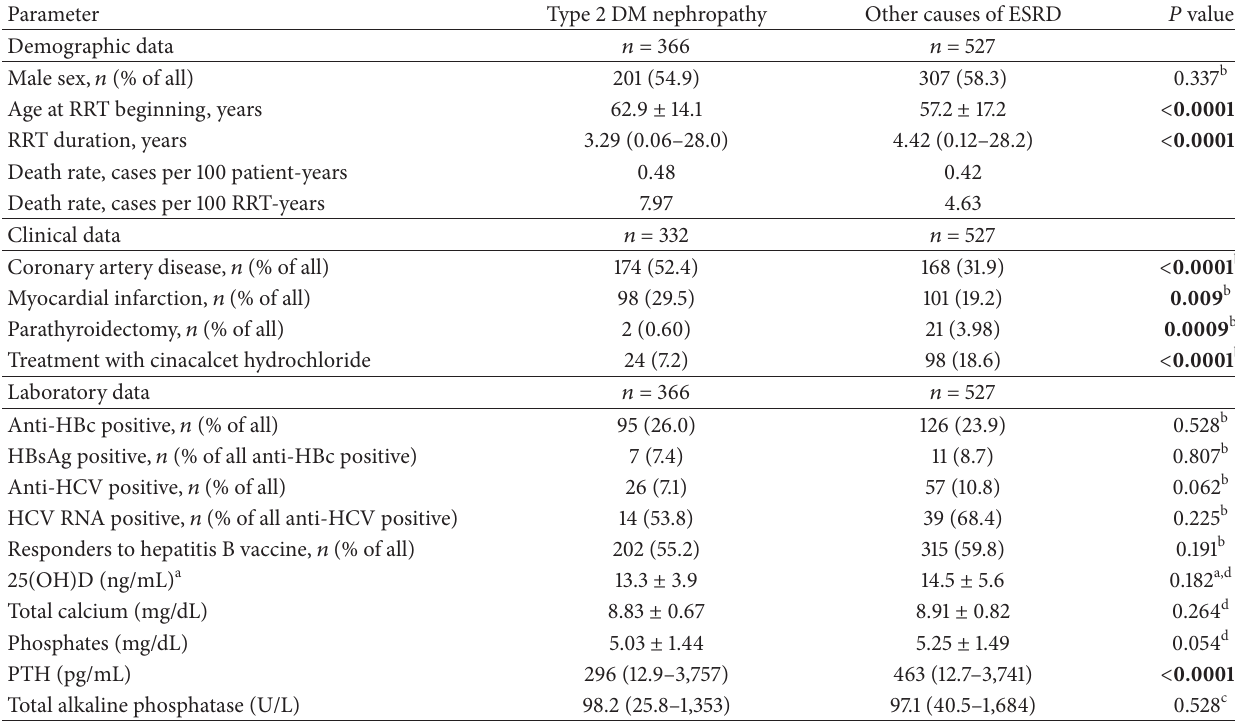
Table 2: Characteristics of hemodialysis patients ( 𝑛 =